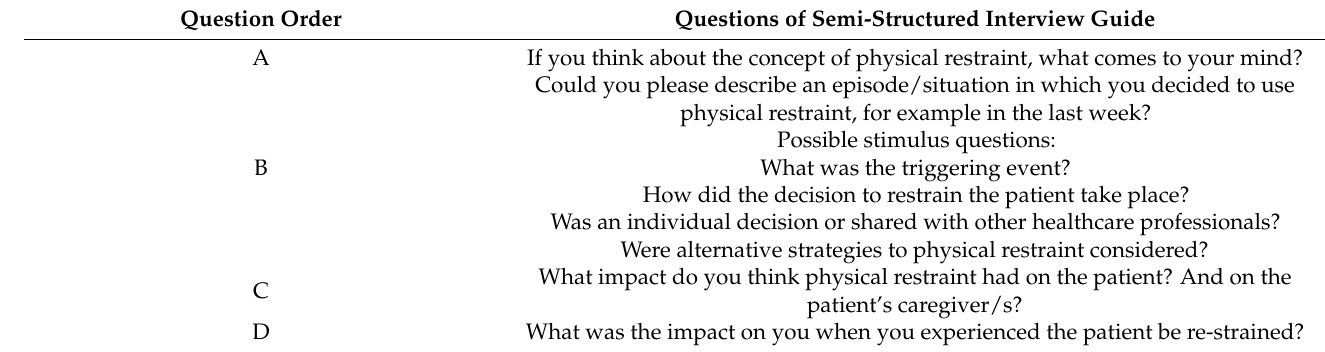
Table 1. Questions of semi-structured interview